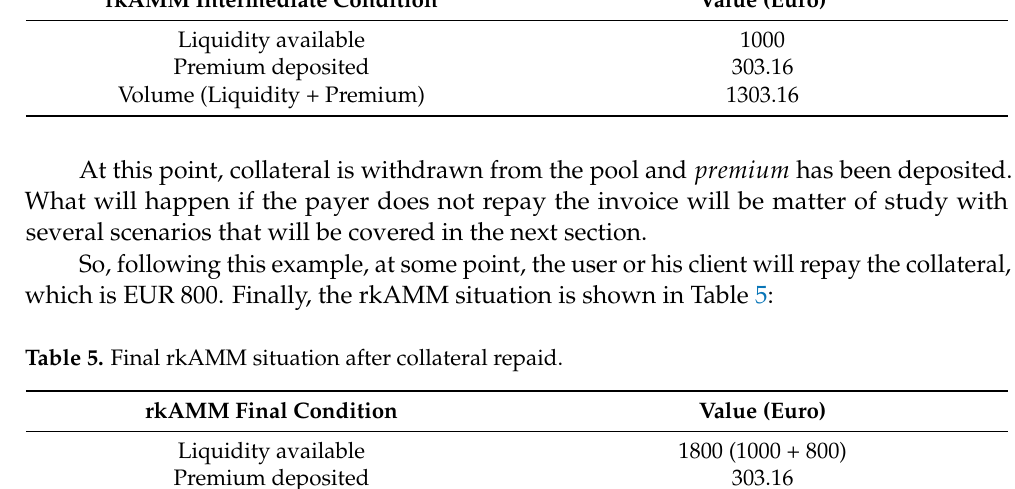
Table 4. Intermediate rkAMM situation after accepting an invoice (collateralization). rkAMM Intermediate Condition